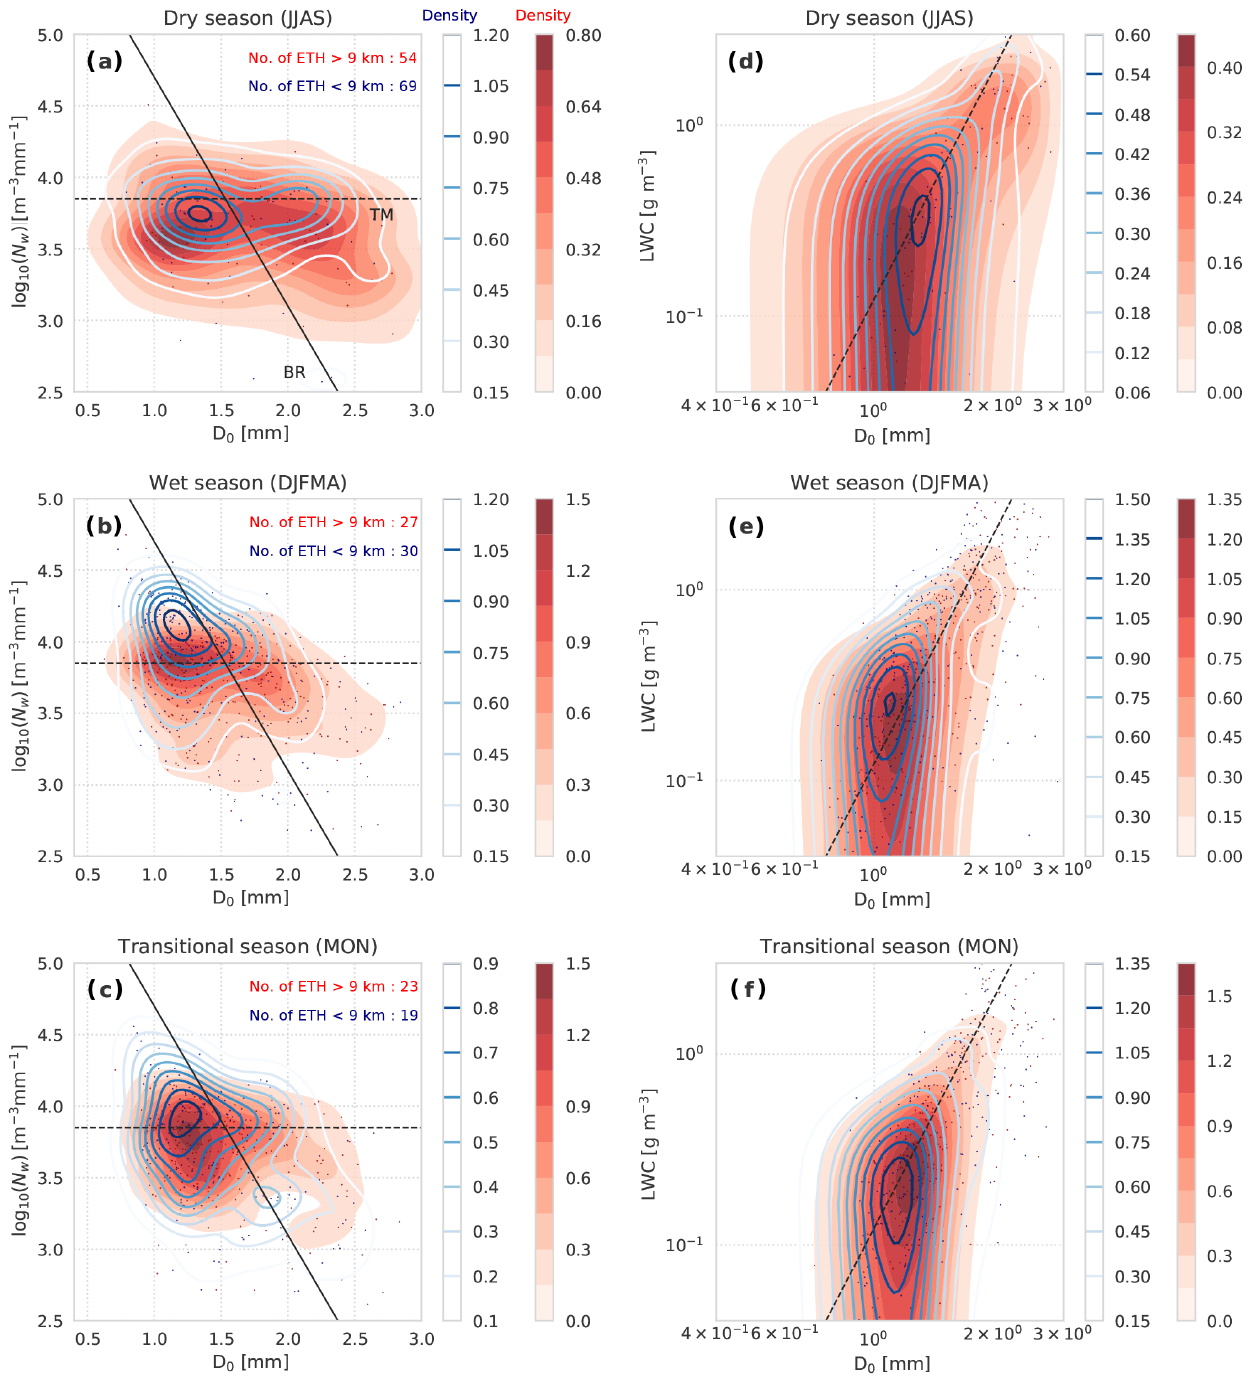
Figure 13. Scatter plots of log 10 ( N w ) versus D 0 and LWC versus D 0 for RWP-based convective DSDs, for dry (a, d) , wet (b, e) and transitional (c, f) seasons. The contours represent the congestus (ETH < 9km, blues) and deep (ETH > 9km, reds) convective